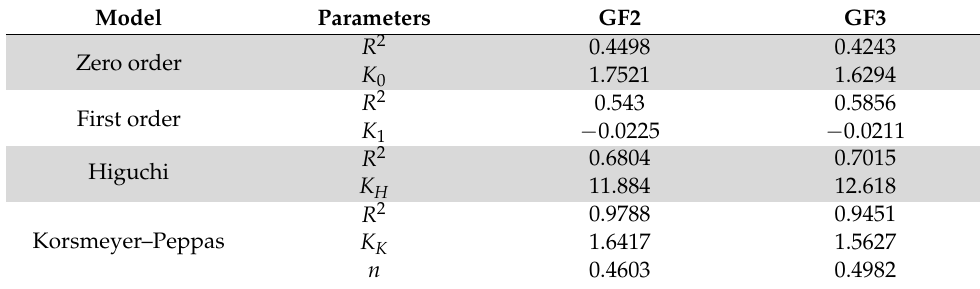
Table 2. Mathematical modeling of GS release from AXSA